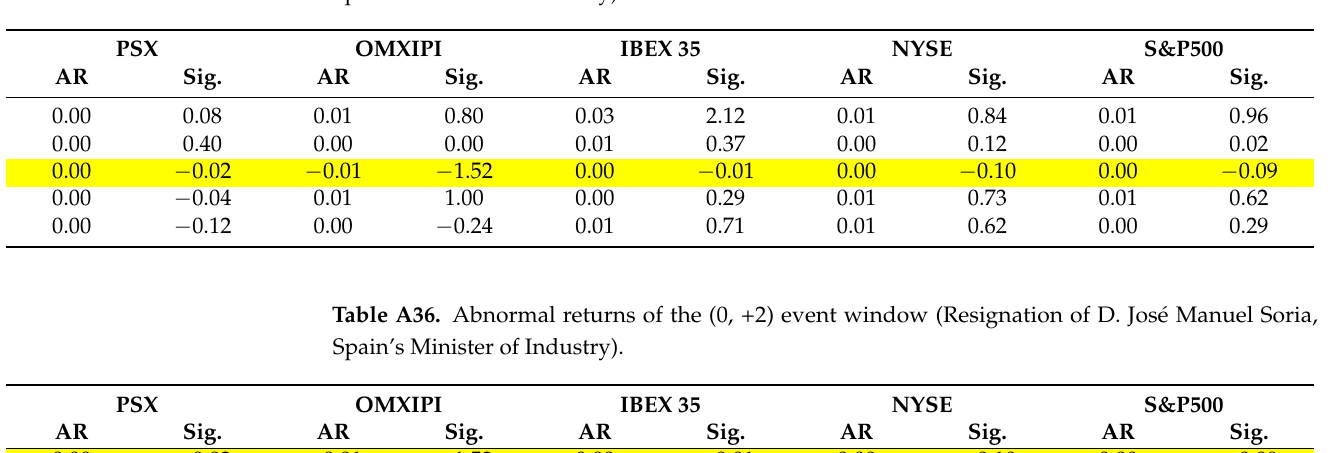
Table A35. Abnormal returns of the ( − 2, +2) event window (Resignation of D. Jos é Manuel Soria, Spain’s Minister of Industry).